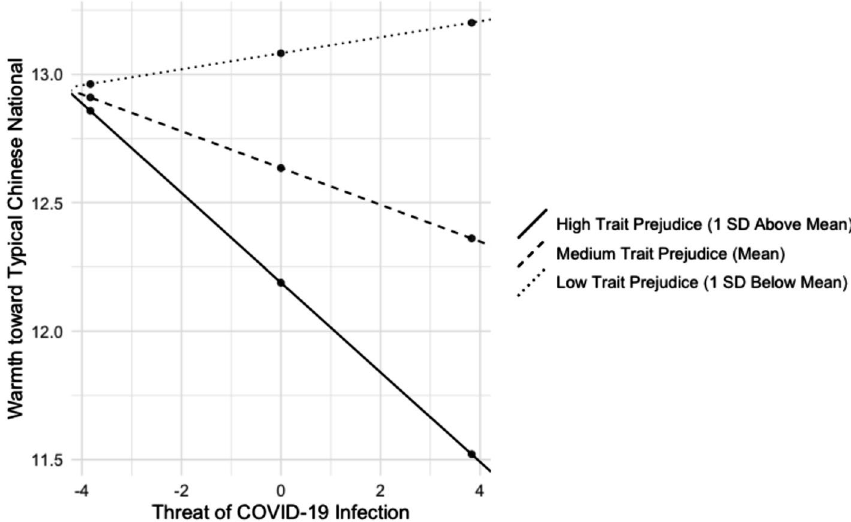
Figure 2. Results from the moderation analysis assessing whether trait-level prejudice impacts the relationship between threat of COVID-19 infection and warmth toward the typical Chinese national. The plotted lines reflect the simple slopes (i.e., the regression of warmth toward Chinese nationals on individual threat of COVID-19 infection) at one standard deviation above the mean of trait prejudice (solid), one standard deviation below the mean of trait prejudice (dotted), and at the mean of trait prejudice (dashed). Participants who scored low and medium on trait-level prejudice do not show a significant relationship between threat of COVID-19 infection and warmth toward the typical Chinese national. In contrast, individuals high on trait prejudice show a significant, negative relationship between threat of COVID-19 infection and warmth toward the typical Chinese